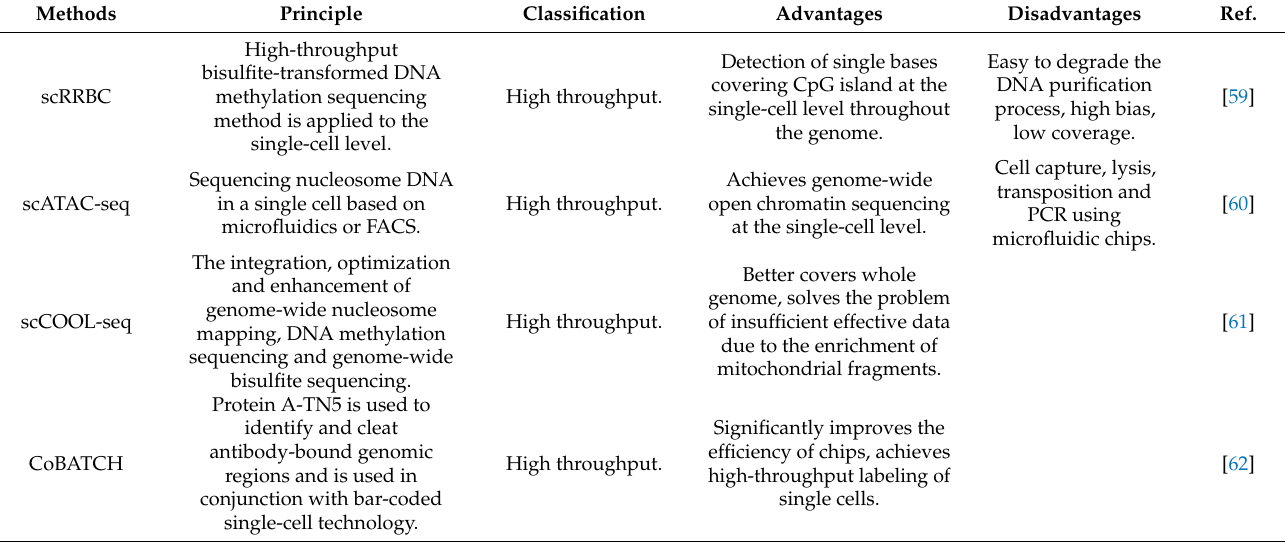
Table 5. Single-Cell Epigenetic